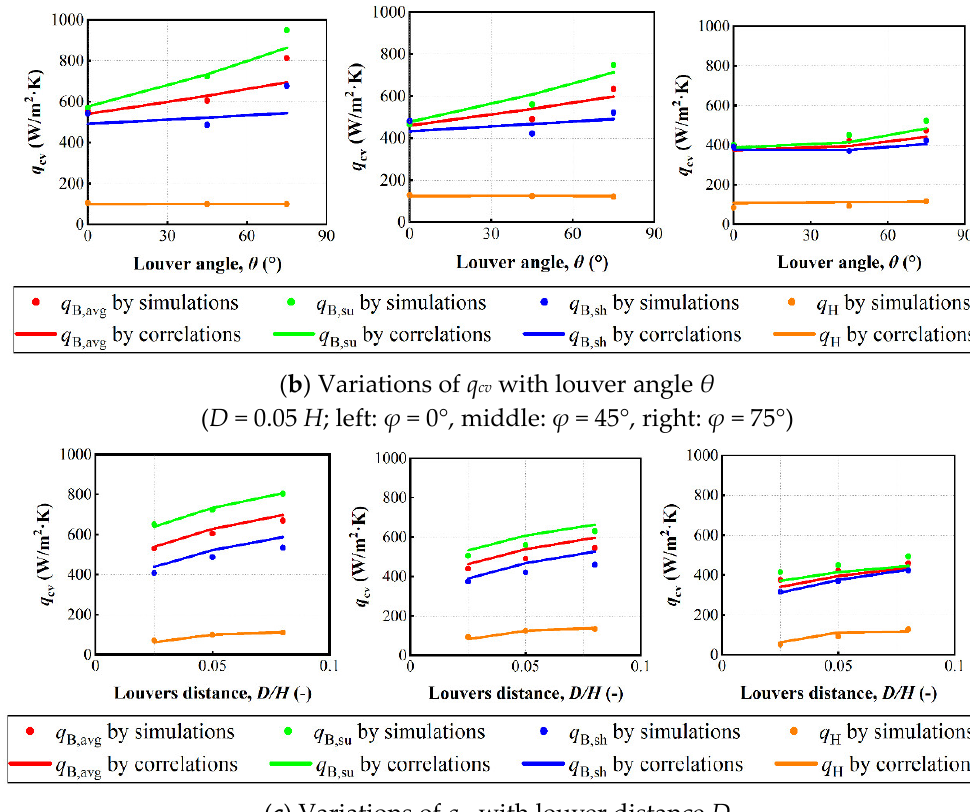
Figure 15. Comparison of q cv at the façade and blinds between simulations and correlations ( Re B = 9.5 × 10 4 , Re H = 10.9 × 10 4 , B / H = 0.035, T H − T a = 10 °C, T B − T a = 20 °C).